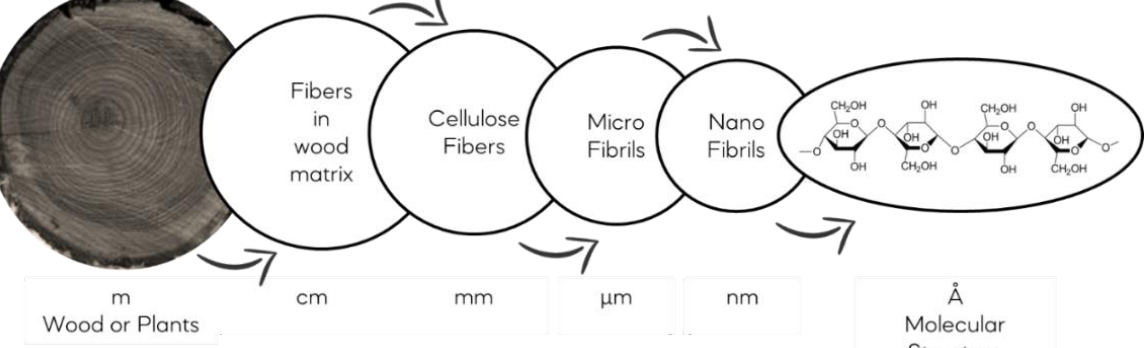
Figure 1. Inner structure of cellulose obtained from lignocellulosic biomass.